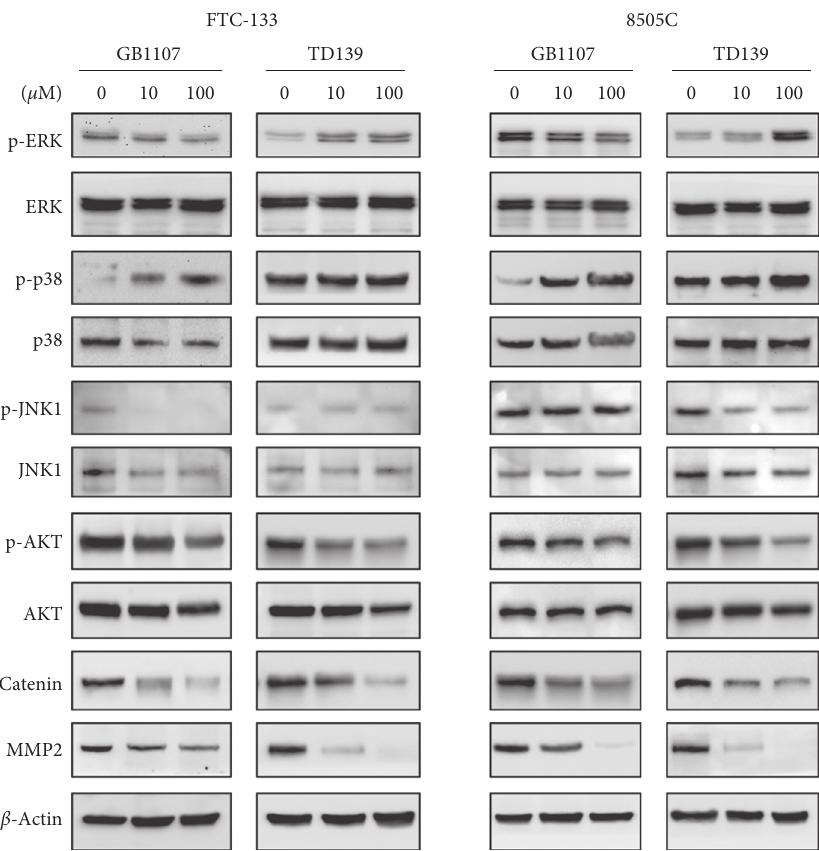
Figure 6: Expression of relevant signaling molecules following treatment with galectin-3 inhibitors (GB1107 and TD139) in FTC-133 and 8505C human thyroid cancer cells. The protein expression was determined using immunoblotting after 24-h